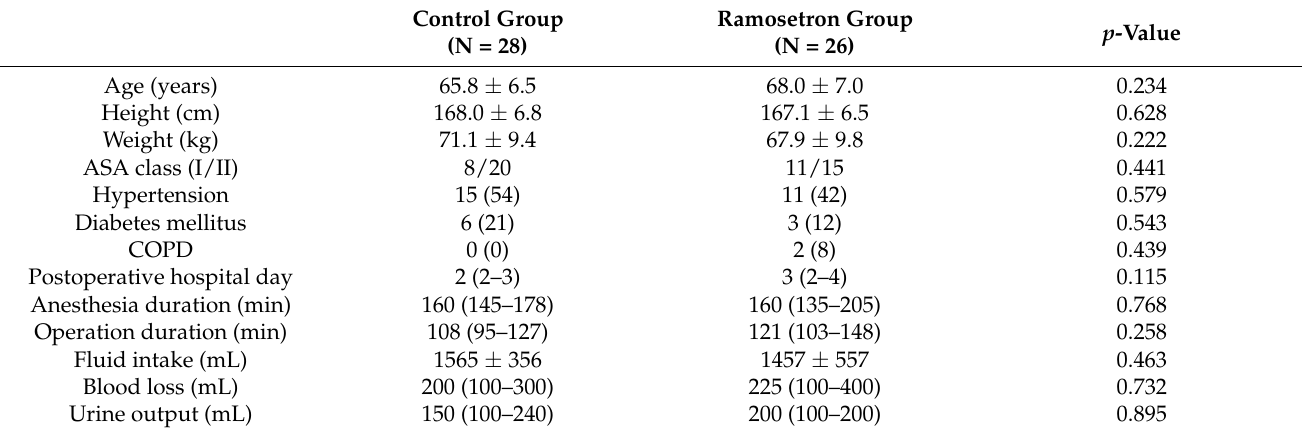
Table 1. Patient characteristics and intraoperative variables.